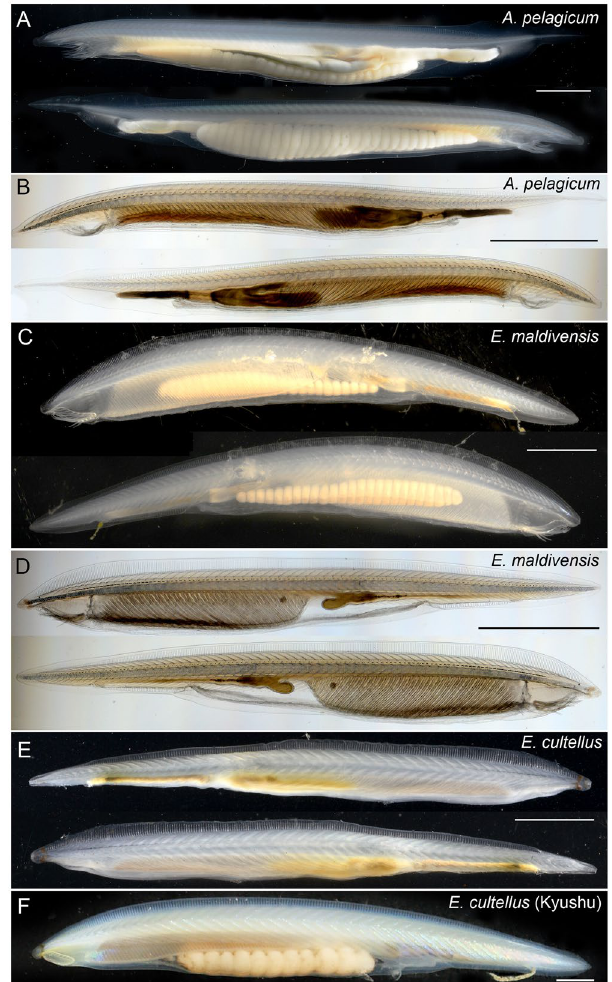
Figure 5. Left and right lateral views of dextral gonad amphioxus species. ( A ) Live Asymmetron pelagicum from Nanwan Bay under incident light. ( B ) Live A. pelagicum without gonads from Nanwan Bay under transmitted light. ( C ) Live Epigonichthys maldivensis from Nanwan Bay under incident light. ( D ) Live E. maldivensis without gonads from Nanwan Bay under transmitted light. ( E ) Fixed E . cultellus from the South China Sea under incident light. ( F ) Lateral view of live E. cultellus from northern Kyushu under incident light. Scale bars 2